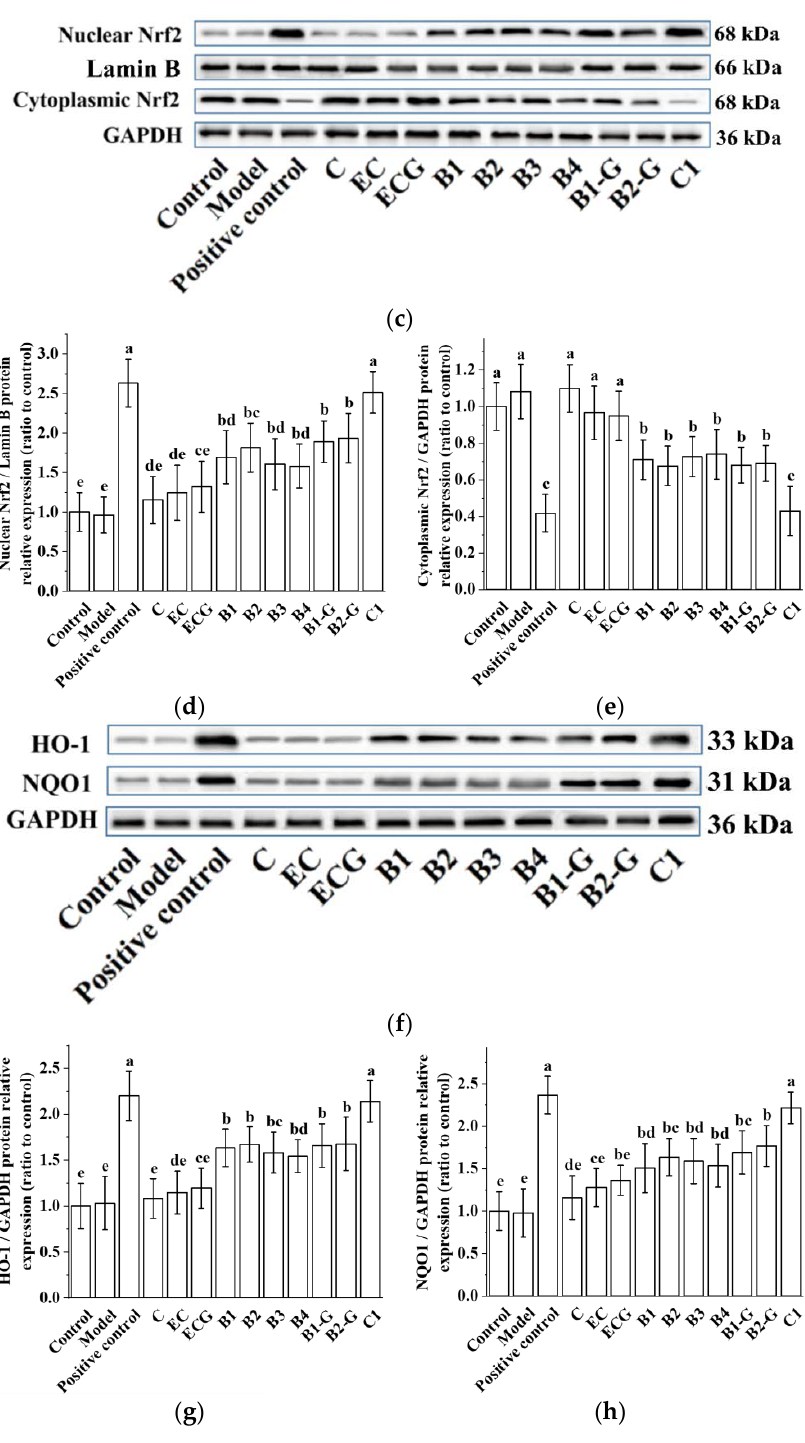
Figure 5. Effects of different structural procyanidins on the nuclear factor-erythroid 2-related factor 2 (Nrf2)/ARE Pathway in the PC12 cell PD model. ( a ) Protein levels of Nrf2, as determined by Western blotting. ( b ) Nrf2/GAPDH protein relative expression (ratio to control). ( c ) Protein expression levels of nuclear Nrf2 and cytoplasmic Nrf2, as determined by Western blotting. ( d ) Nuclear Nrf2/LaminB protein relative expression (ratio to control). ( e ) Cytoplasmic Nrf2/GAPDH protein relative expression (ratio to control). ( f ) Protein levels of HO-1 and NQO1, as determined by Western blotting; ( g ) HO-1/GAPDH protein relative expression (ratio to control). ( h ) NQO1/GAPDH protein relative expression (ratio to control). Control, Blank control group; Model, MPP + (1.5 mM); Positive control, Deprenyl (30 µM) + MPP + (1.5 mM); C: C (5 µM) + MPP + (1.5 mM); EC: EC (5 µM) + MPP + (1.5 mM); ECG: ECG (5 µM) + MPP + (1.5 mM); B1: B1 (5 µM) + MPP + (1.5 mM); B2: B2 (5 µM)